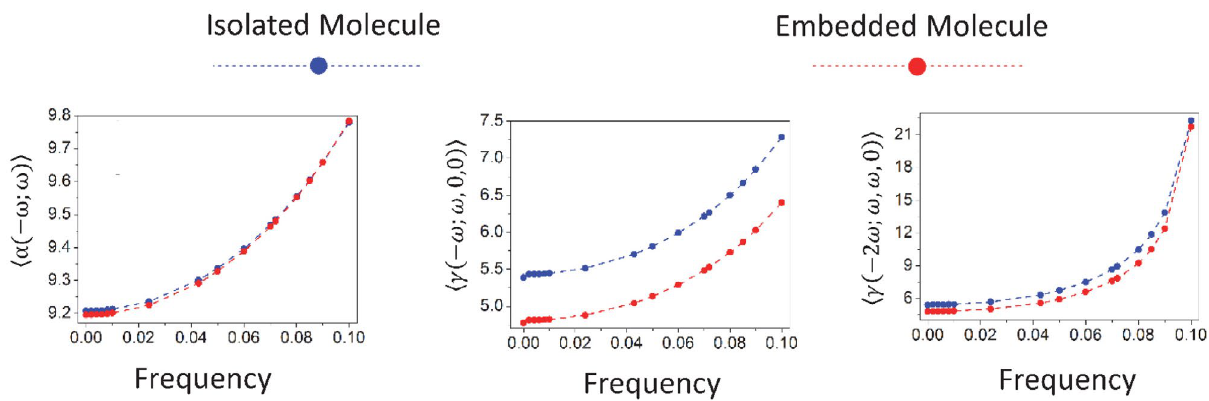
Figure 7: Dynamic evolution of the calculated values for: a) average linear polarizability ‹ α(–ω; ω) › (10 –24 esu ); b) average second hyperpolarizabili- ty ‹ γ(–ω; ω, 0, 0) ›(10 –36 esu ); c) average second hyperpolarizability ‹ γ(–2ω; ω, ω, 0) › (10 –36 esu ) for the compound CAD(C 5 H 8 O 2 ).